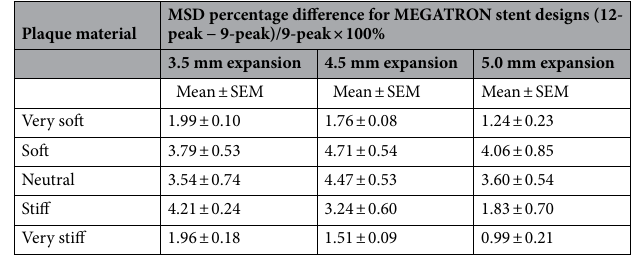
Table 3. Relative difference of MEGATRON 12-peak design versus 9-peak design across different homogeneous plaque conditions at different expansion diameters.